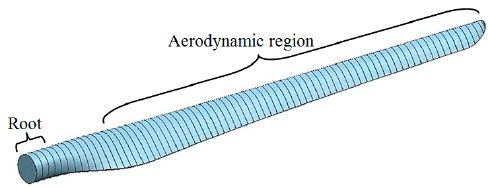
Figure 1. The geometry shape of the blade.